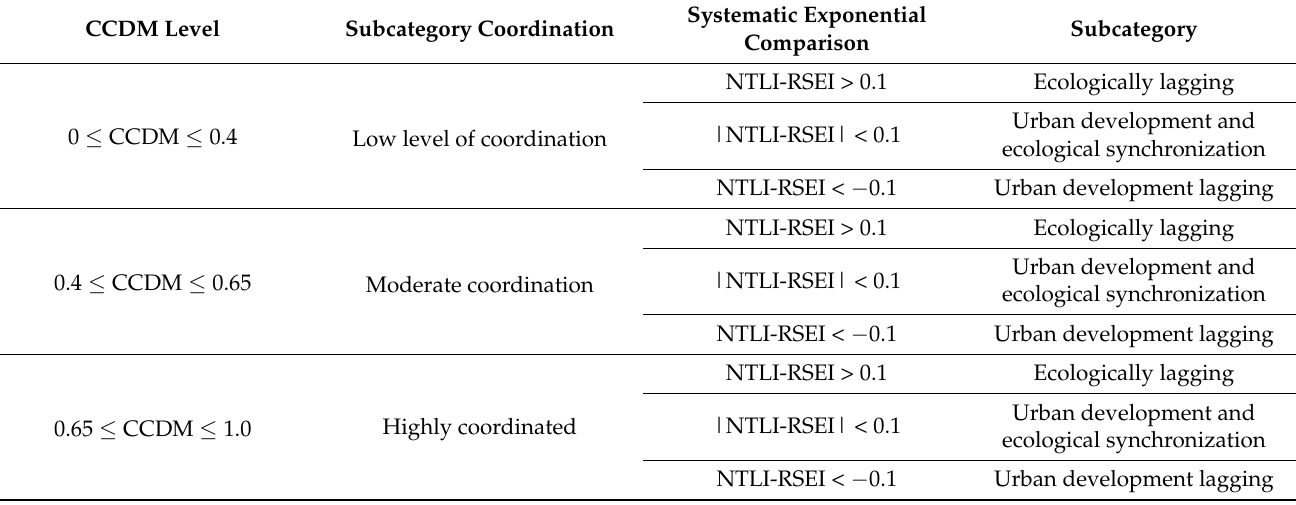
Table 2. CCDM classification